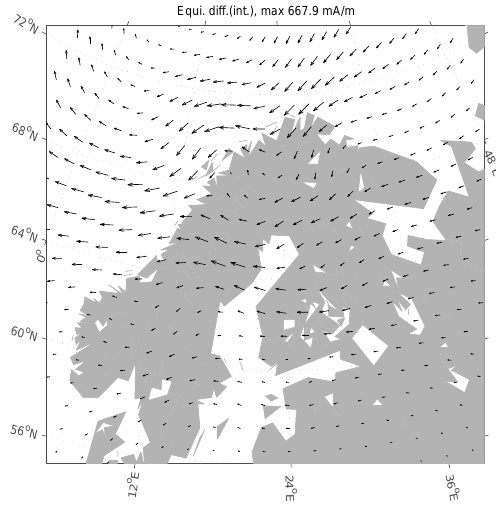
Fig. 9. Difference between the ionospheric equivalent currents de- termined from the total and external parts of the modeled magnetic field. Magnetic field data from the continental IMAGE array loca- tions for time 01:55 UT are used (see Fig. 6). The maximum current amplitude (difference) is indicated in the title of the figure.